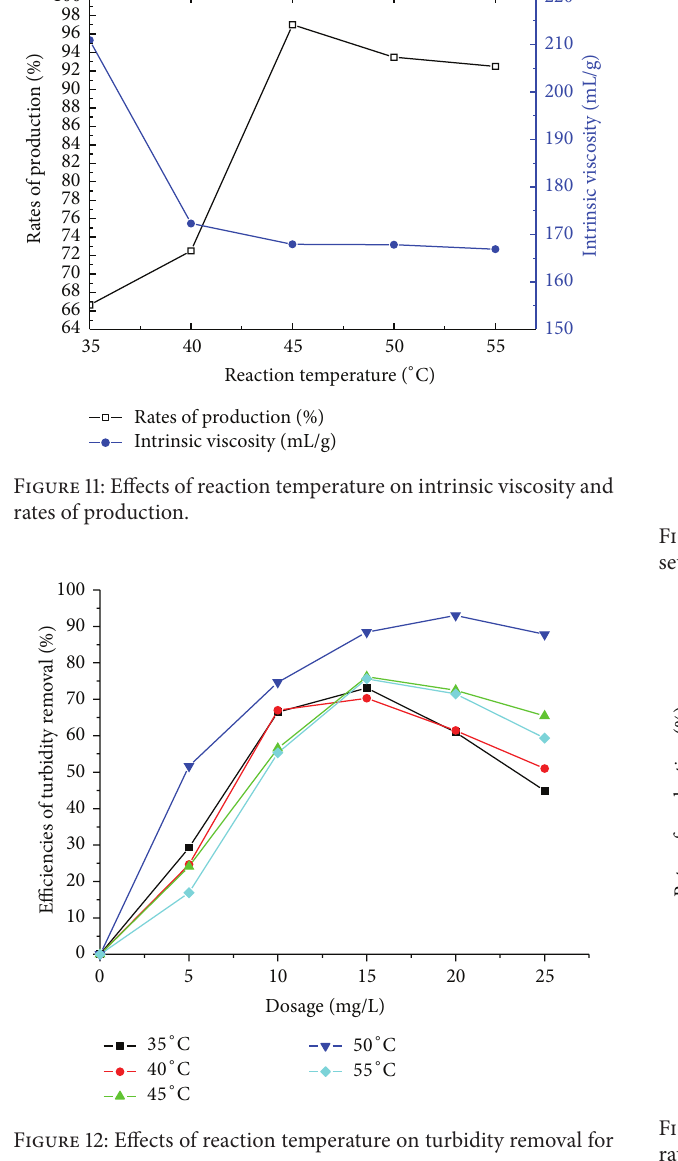
Figure 12: Effects of reaction temperature on turbidity removal for sewage.